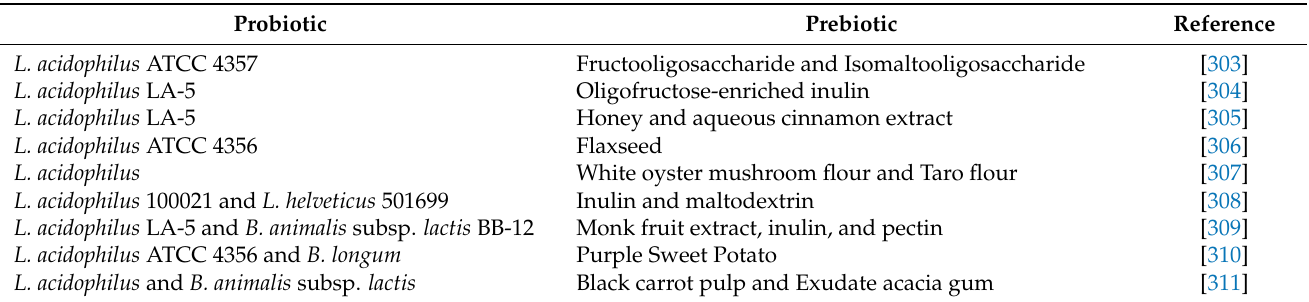
Table 4. Some of the probiotics and prebiotics that have been incorporated into synbiotic yogurt.